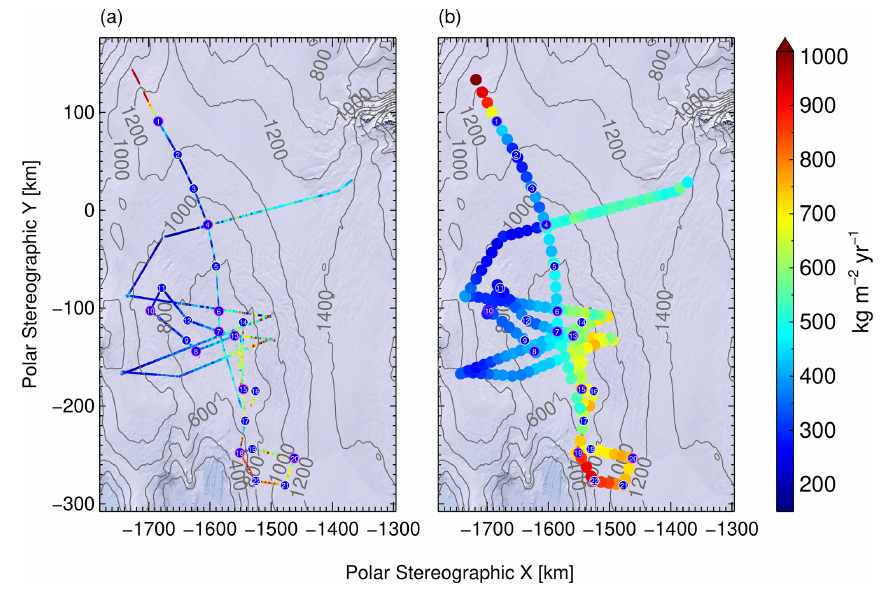
Figure 5. Traced annual mean SMB between November 2004 and December 2014 from ASIRAS soundings with overlaid contour lines in metres from a digital elevation model (Helm et al., 2014) and Landsat background imagery (U.S. Geological Survey, 2007). Circles with numbers denote the iSTAR sites. (a) High spatial SMB resolution; (b) smoothed and downsampled SMB estimates.